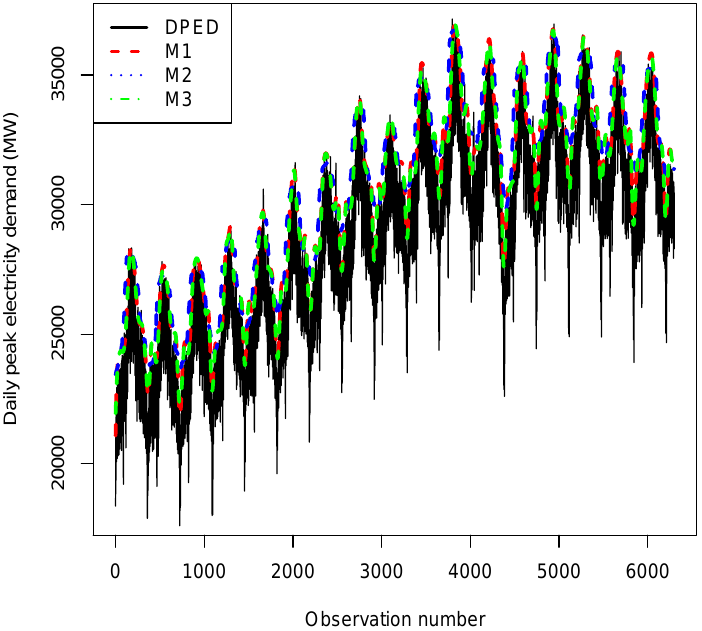
Figure 3. DPED superimposed with the 0.95 quantiles from the M1, M2 and M3